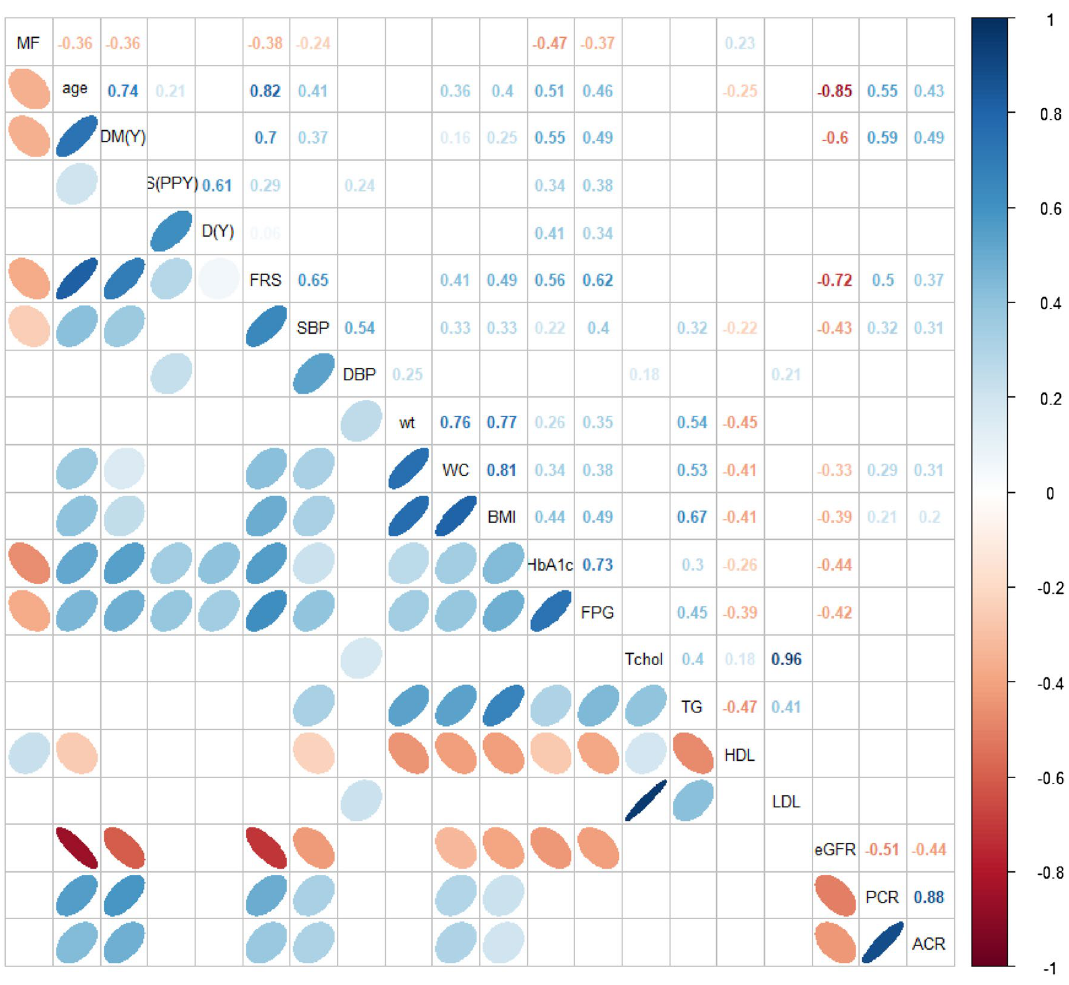
Figure 2. Correlations between cardiovascular risks and the membrane fluctuation of red blood cells. The upper part of the figure shows Spearman’s correlation coefficients ( ρ values) and the lower side of the figure shows correlations by direction and thickness. Only significant correlations ( P < 0.05) are retained in the picture. MF, membrane fluctuations; DM(Y), duration of diabetes mellitus (year); S(PPY), smoking duration (packs per year); D(Y) drinking duration (years); FRS, 10-year coronary heart disease risk by Framingham risk score; SBP, systolic blood pressure; DBP, diastolic blood pressure; wt, weight; WC, waist circumference; BMI, body mass index; HbA1c, glycated haemoglobin; FPG, fasting plasma glucose; Tchol, total cholesterol; TG, triglycerides; HDL, high-density lipoprotein cholesterol; LDL, low-density lipoprotein cholesterol; eGFR, estimated glomerular filtration ratio; PCR, urinary protein-to-creatinine ratio; ACR, urinary albumin-to-creatinine ratio. Model 1 Model 2 Variables Variables Crude odds ratio Adjusted odds